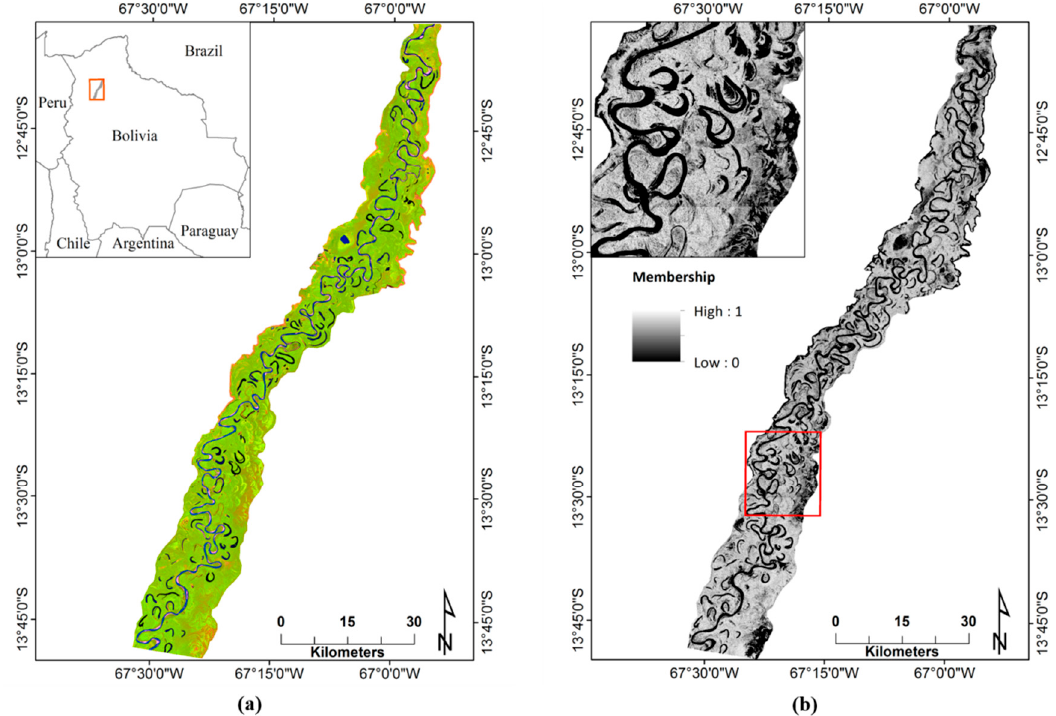
Figure 2. ( a ) Landsat 5 Thematic Mapper (TM) image of the study area, acquired on 2 August 1987, with bands 4,5,1 as R,G,B (pixel size = 30 m); ( b ) fuzzy membership image for the forest class, with example enlarged spatial subset given in the upper left to facilitate illustration of floodplain complexity, and location of spatial subset designated by red box. The study area extends between approximately 12°31 ′ 34 ′′ and 13°49 ′ 19 ′′ South latitude, and between 66°54 ′ 04 ′′ and 67°32 ′ 05 ′′ West longitude, an area comprising ~2060 km 2 .